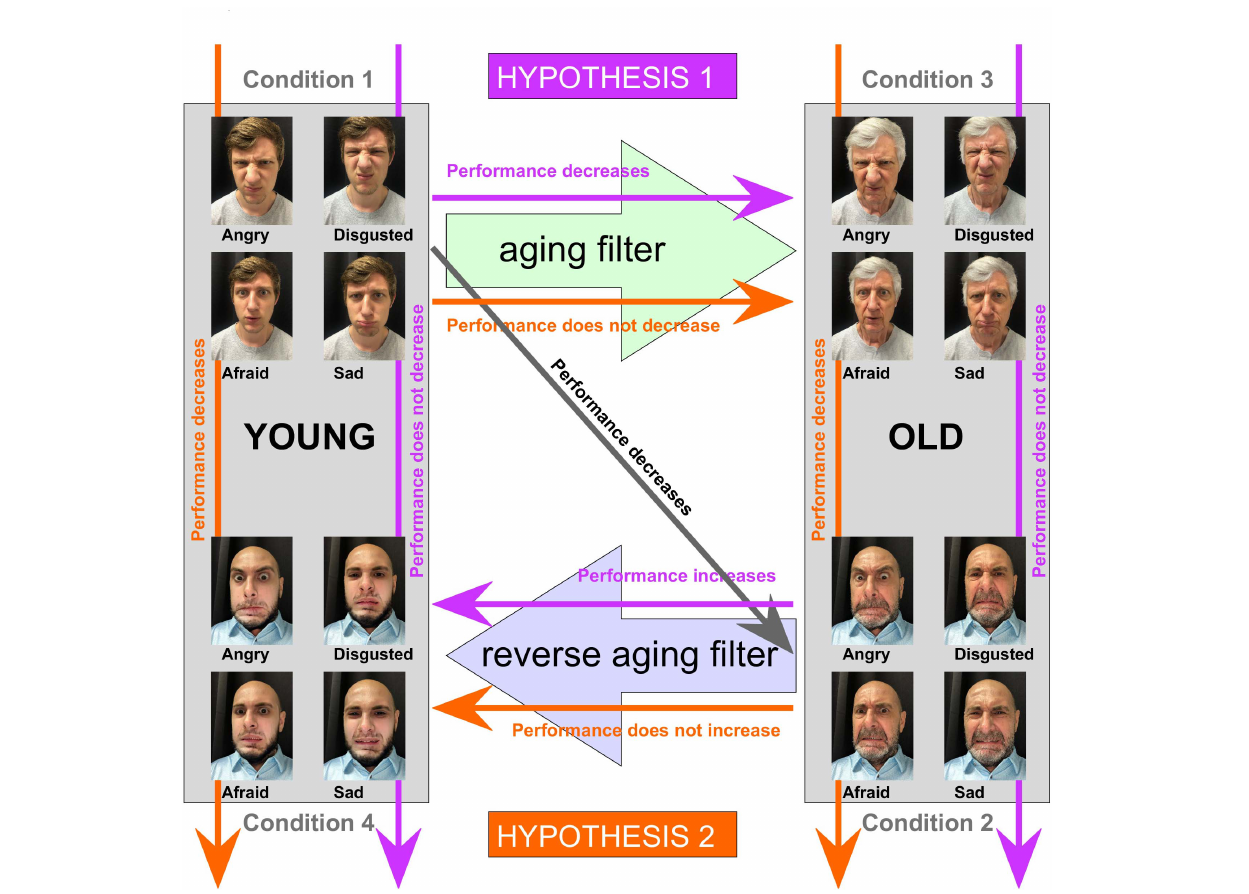
FIGURE 1 | Example stimuli and schematic representation hypotheses. Top Left: an example set (not used for the actual experiment, but representative) to illustrate the stimuli employed for Condition 1, showing a young adult posing for four different negative facial expressions (sadness, disgust, fear, and anger; the neutral expression, also used for the experiment is not shown). Top right: example set to illustrate how the stimuli for condition 3, using an aging filter, were generated. Bottom right: an example set (not used for the actual experiment, but representative) to illustrate the stimuli employed for Condition 2, showing an older male posing for four different negative facial expressions (sadness, disgust, fear and anger; the neutral expression, also used for the experiment is not shown). Bottom left: example set to illustrate how the stimuli for condition 4, using a reversed aging filter, were generated. Colored arrows (purple and orange) and associated text indicate the expected effects on the participant’s ability to identify the correct facial expression in either of two cases: if physical age-related changes such as wrinkles and appearance of the skin hampers identification of the emotional expression (Hypothesis 1, purple), or if weakness of muscle, caused by aging, makes it harder to produce recognizable facial expressions (Hypothesis 2, orange).